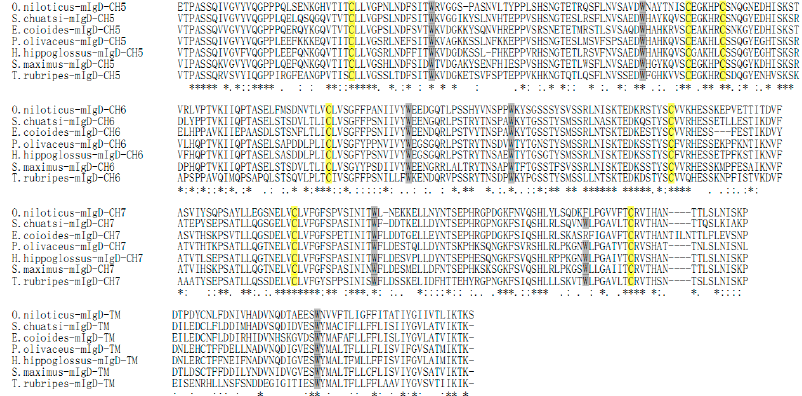
Figure 3. Cont. Figure 3. Cont.